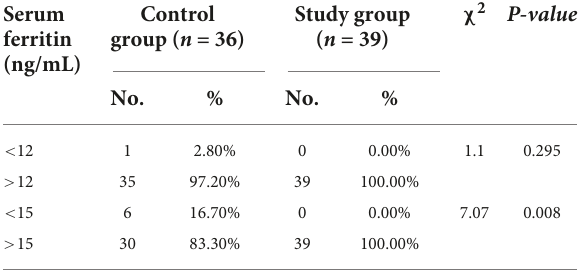
TABLE 4 Comparison of serum ferritin concentration in babies of both groups at 6